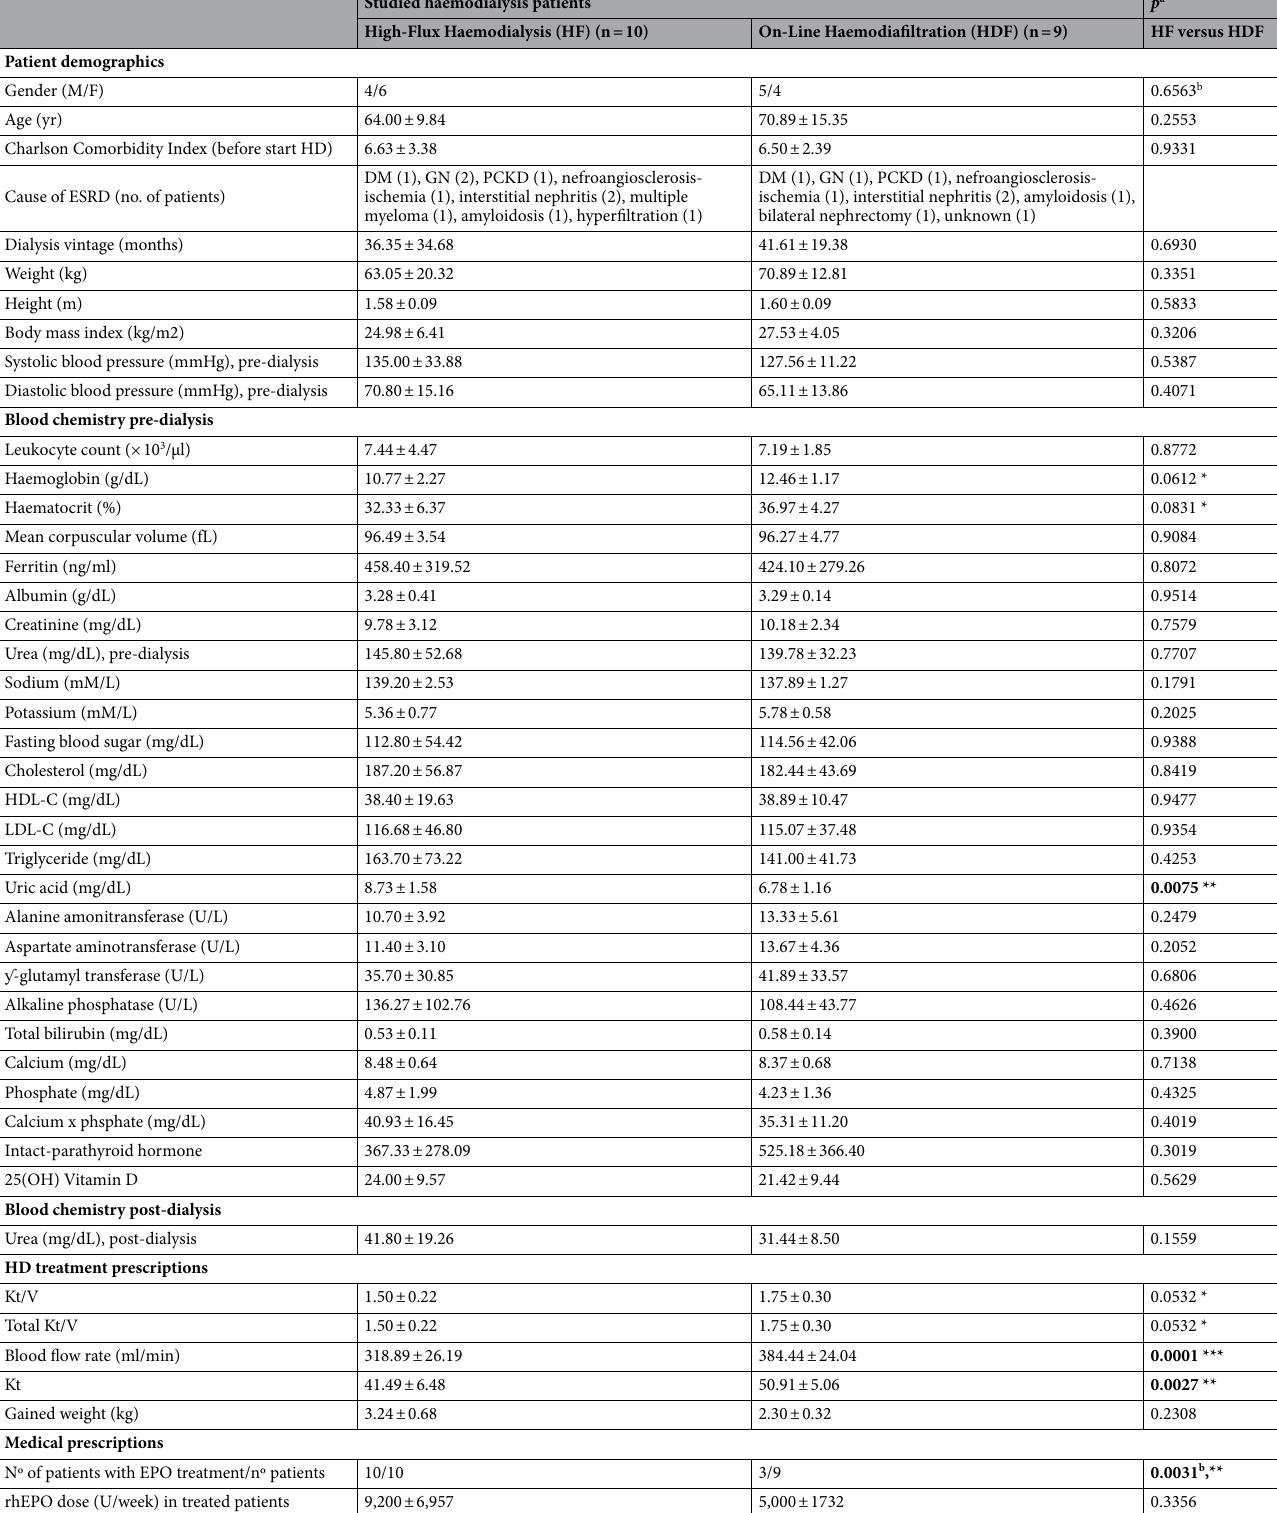
Table 1. Demographics, biochemistry and treatment prescriptions of the studied haemodialysis patients. Data expressed as mean SD. a p values between HF and HDF patients were performed by t-test; b p values by